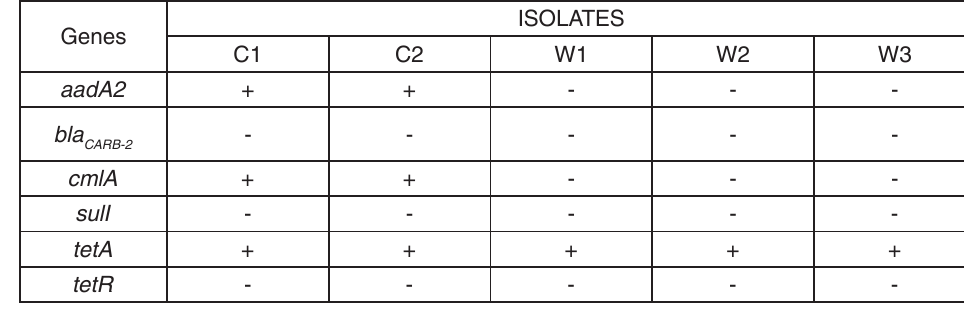
table 4. Antimicrobial resistance genes in the Salmonella isolates